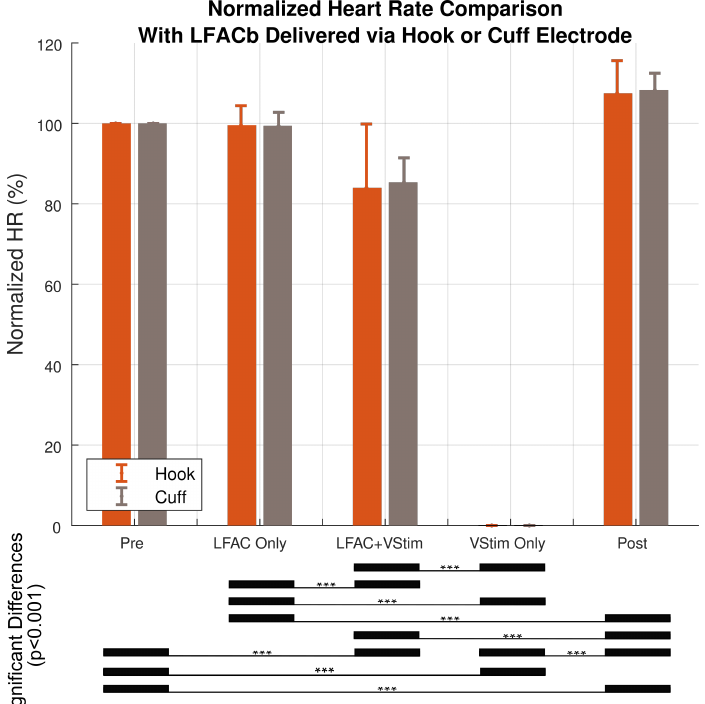
Figure 6. Summary of the effect of stimulation type and electrode type on normalized HR during for each of the five epochs of the experimental sequence (Hook N = 26, Cuff N = 15). There was no significant difference between the hook and cuff (Two-way ANOVA F(1,195) = 0.046, Pr(>F) = 0.830). The error bars indicate standard deviations. *** The significant differences ( p = 2 × 10 only found between